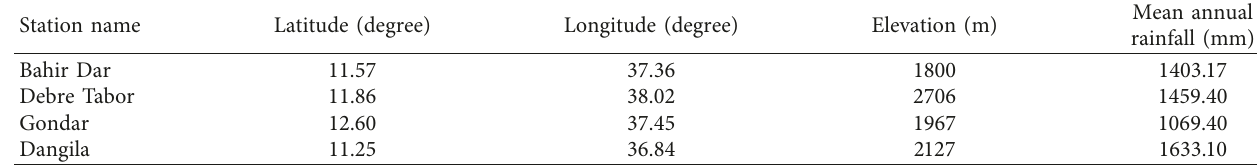
Table 1: Stations of the studying area, locations, elevations, and mean annual